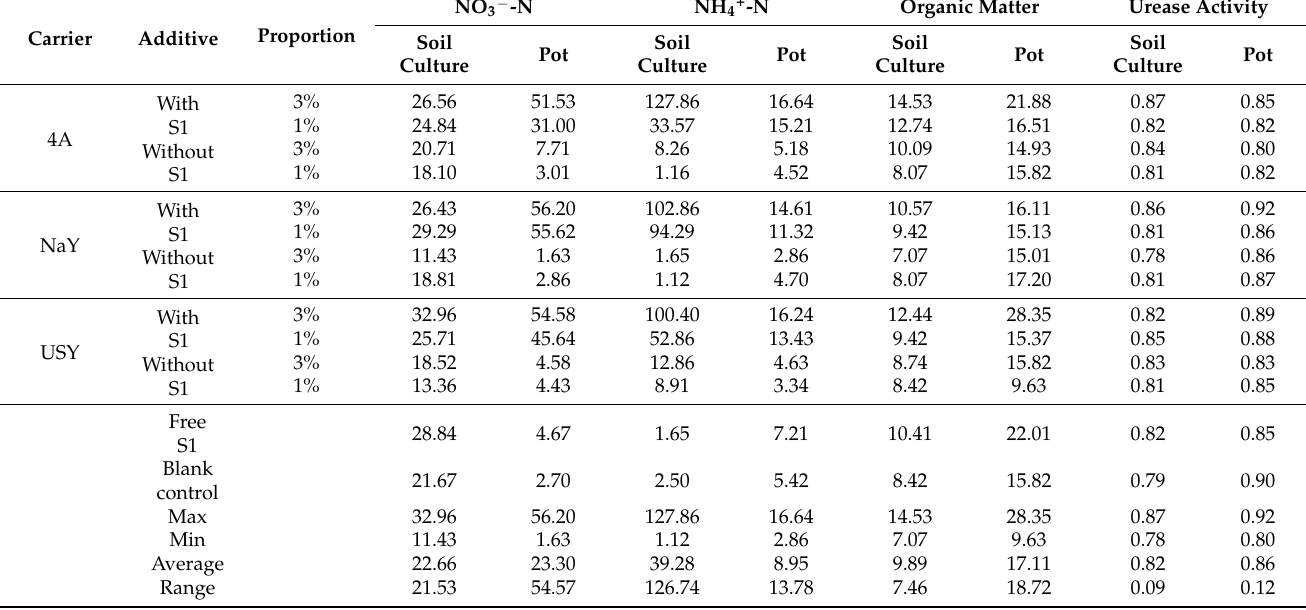
Table 6. Changes in soil physical and chemical properties between the soil culture experiment and pot